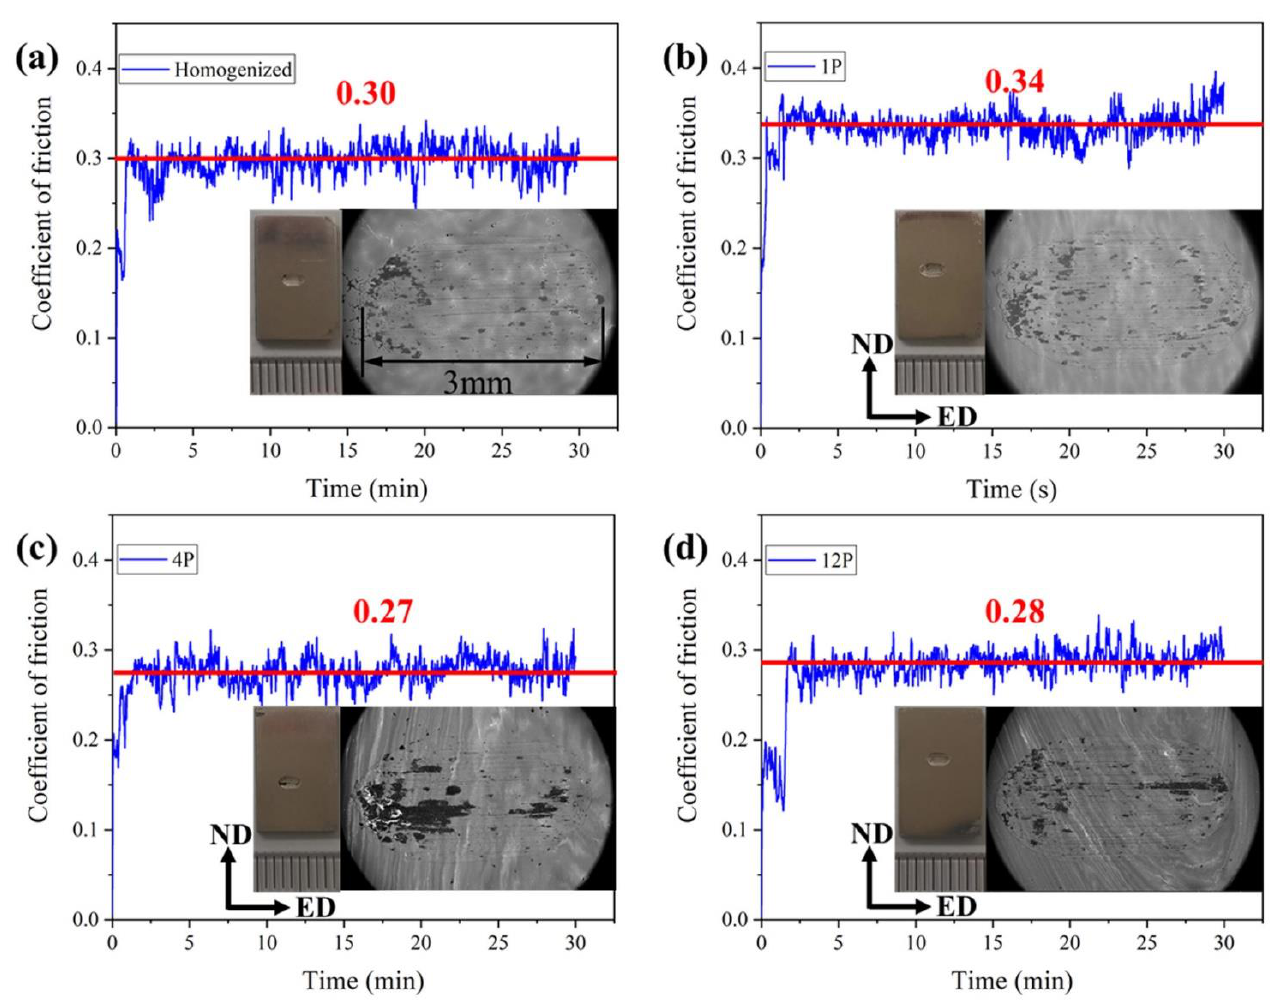
Figure 11. Coefficient of friction fluctuation with time for ( a ) Homogenized and ( b ) 1P; ( c ) 4P; ( d ) 12P processed samples with the corresponding macrographs and SEM images, where the SEM images are in backscattered electron signal (BSE).